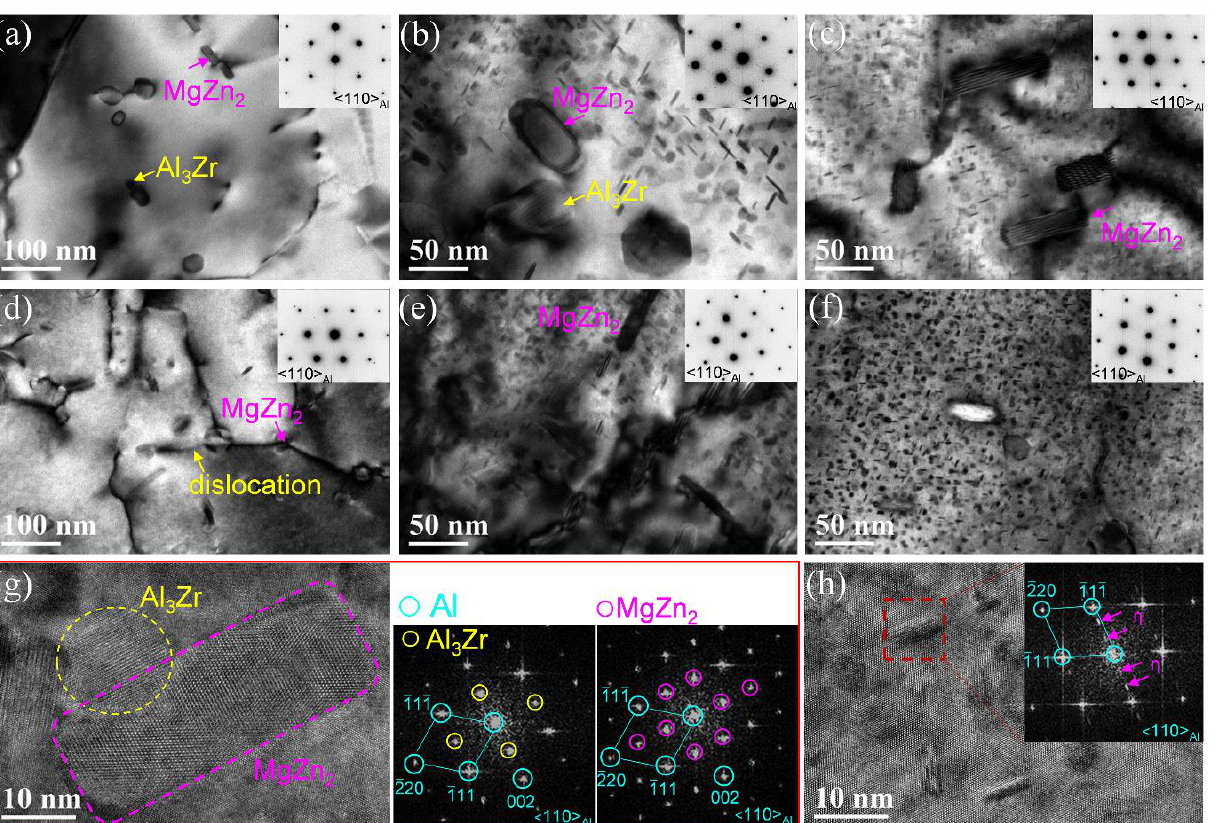
Figure 6. TEM and HRTEM images of the precipitates in LHZ and HHZ of the builds in the different aging states: ( a ) LHZ in the NA-7 d state; ( b ) LHZ in the 120 °C × 24 h state; ( c ) LHZ in the 100 °C × 48 h state; ( d ) HHZ in the NA-7 d state; ( e ) HHZ in the 120 °C × 24 h state; ( f ) HHZ in the 100 °C × 48 h state; ( g ) HRTEM and FFTs of Al 3 Zr and MgZn 2 phases; and ( h ) HRTEM and FFT of η′ phase.